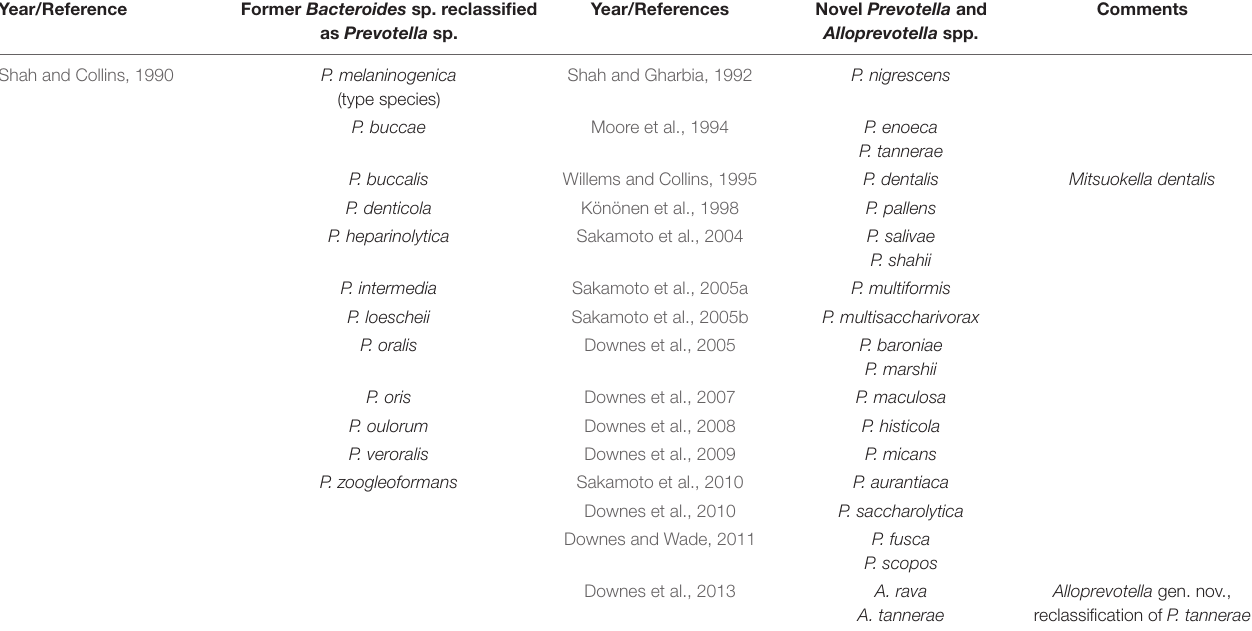
TABLE 1 | Validly published Prevotella and Alloprevotella species with the primary isolation from the human oral cavity. Year/Reference Former Bacteroides sp. reclassified as Prevotella